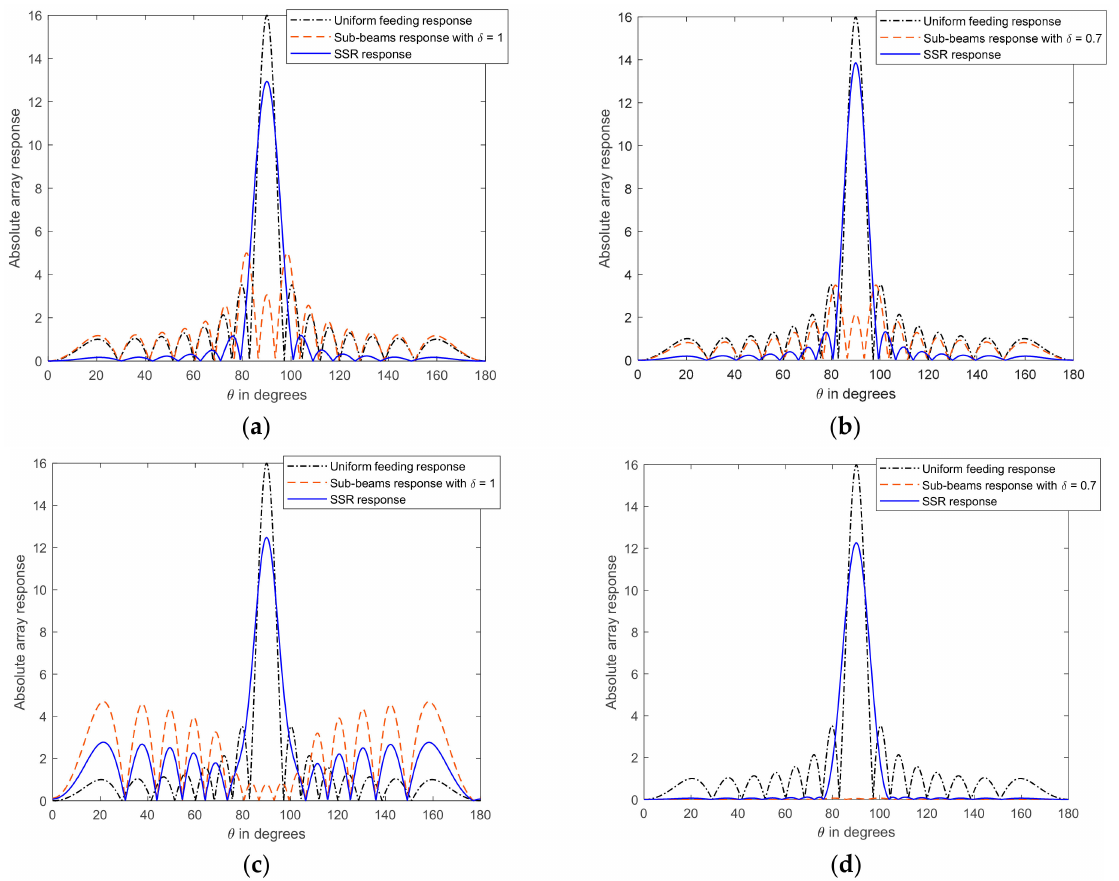
Figure 2. Sub-beams’ formation and SLL reduction at: ( a ) δ = 1, and C = 1, ( b ) δ = 0.7, and C = 1, ( c ) δ = 1, and C = 10, and ( d ) δ = 0.7, and C = 10.